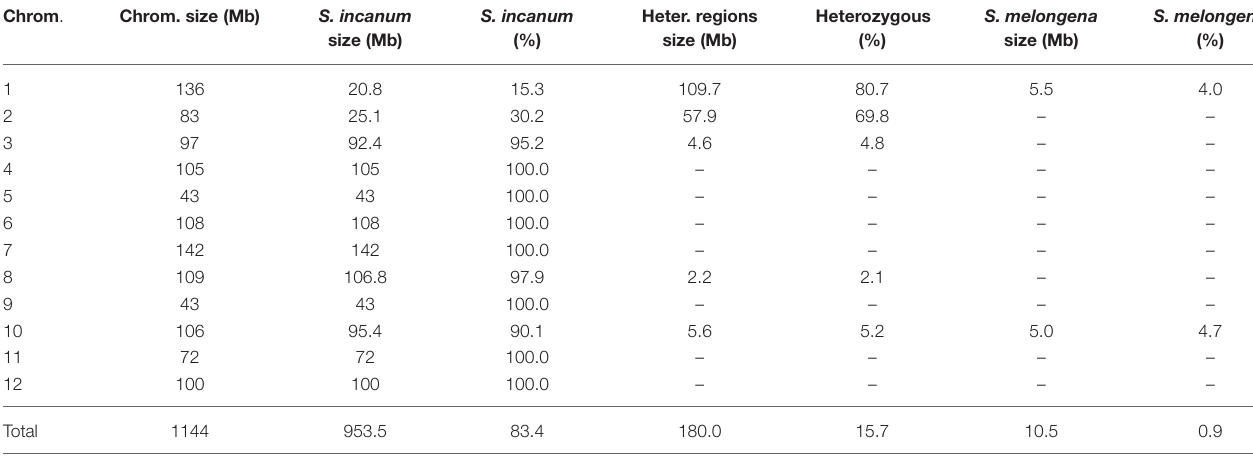
TABLE 1 | Statistics of Solanum incanum MM577 genome coverage in the 73 progenitors (corresponding to selected plants of the BC5S1, BC4S1, and BC2S1 generations) of the advanced backcrosses (ABs) set, after the genotyping by genotyping-by-sequencing (GBS). Chrom .